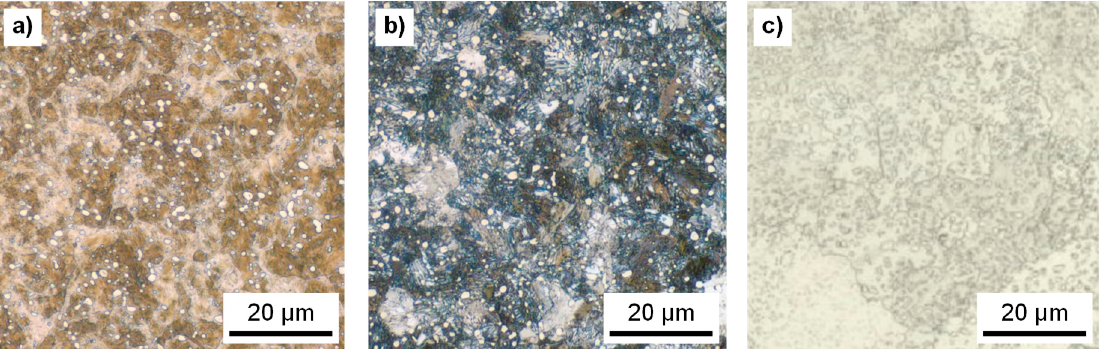
Figure 1. Microstructure of: ( a ) micro samples after roller ball production process; ( b ) micro samples after heat treatment; ( c ) macro samples; etched 25–30 s in 3% alcoholic HNO 3 , all equatorial respectively longitudinal cut images.